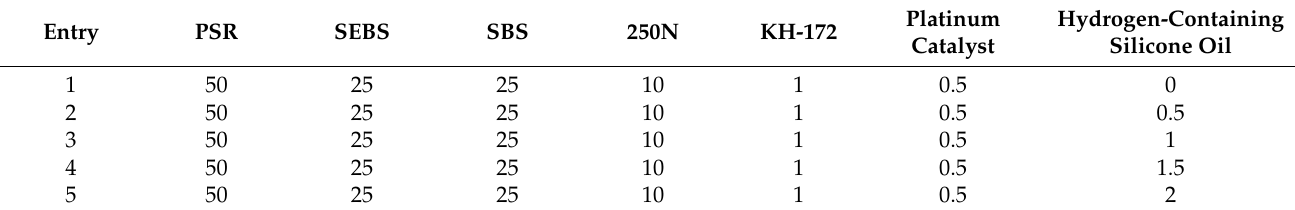
Table 1. TPV dynamic vulcanization experimental formulations (unit: